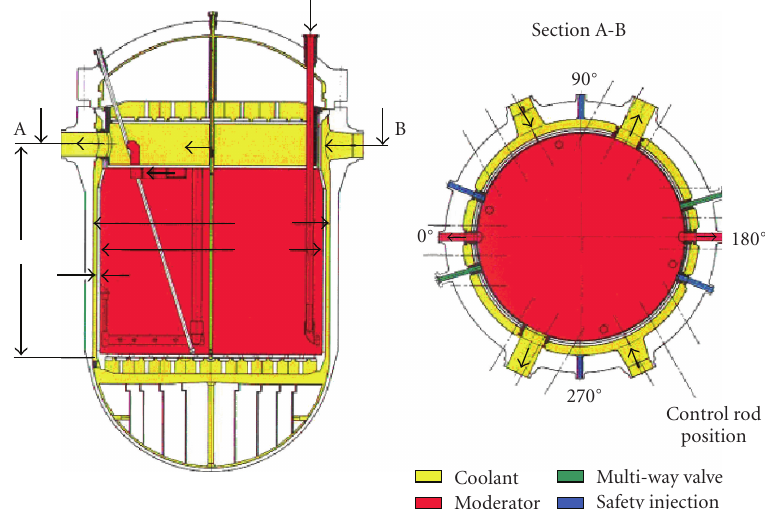
Figure 6: ATUCHA II Reactor Pressure Vessel vertical and horizontal sections.